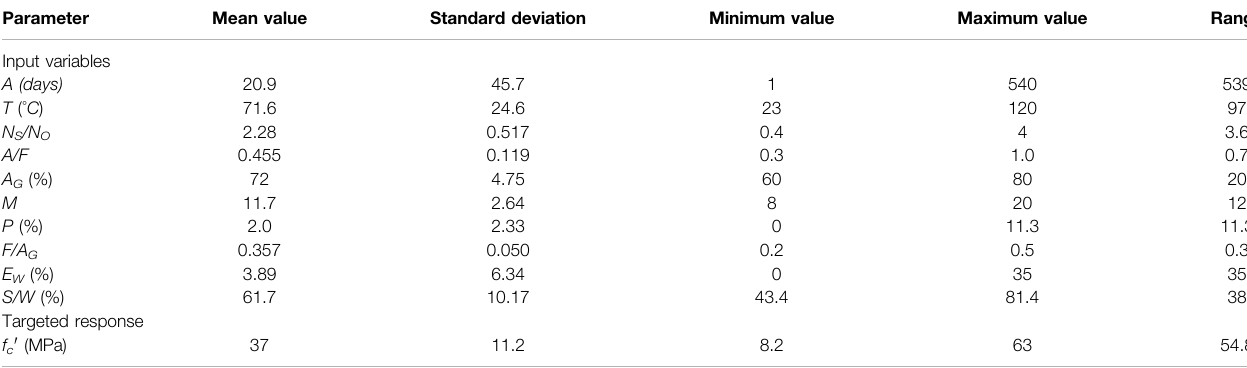
TABLE 3 | Setting of fi tted parameters for ANN and ANFIS models. Type of model